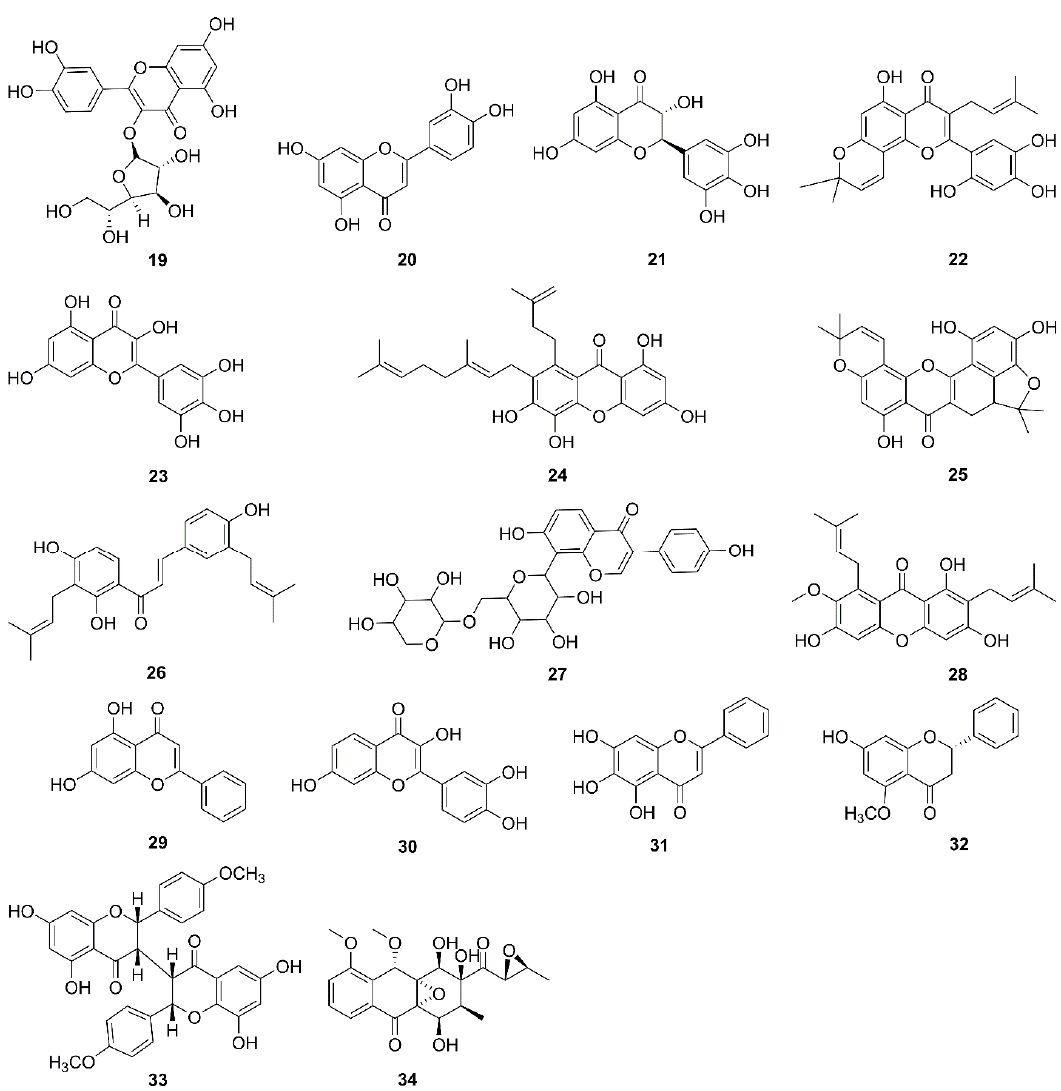
Figure 3. Chemical structures of flavonoids ( 19 – 34 ).